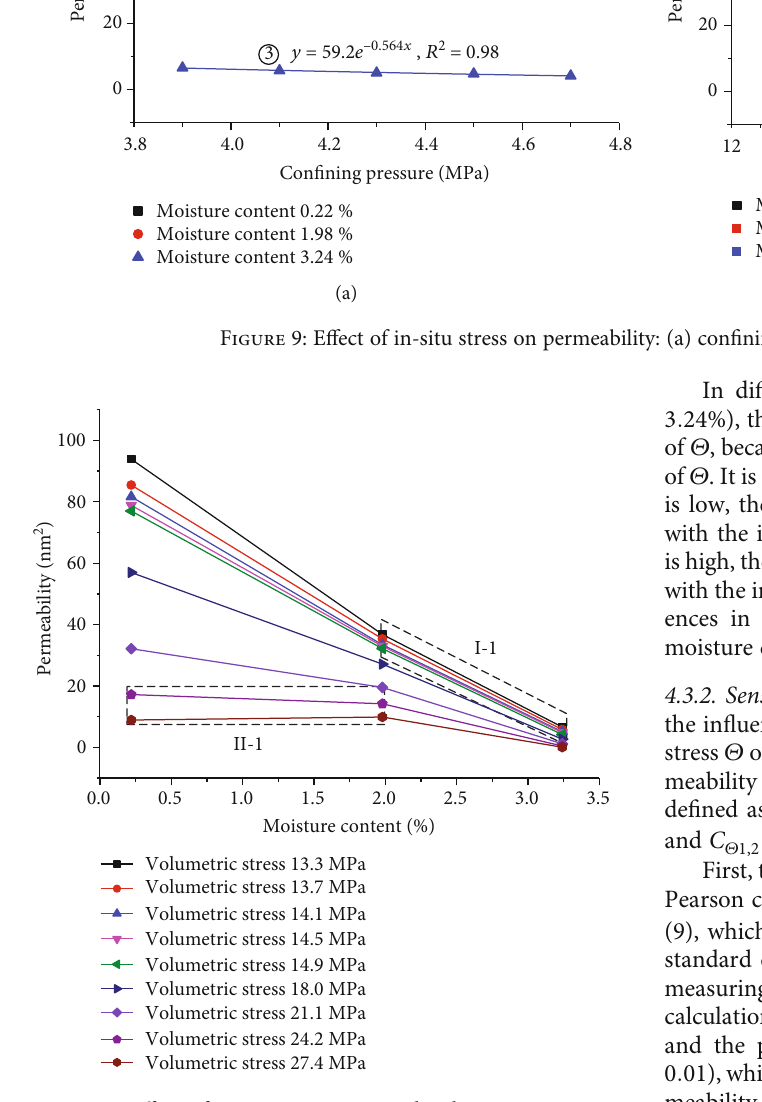
Figure 10: E ff ect of moisture content and volumetric stress on